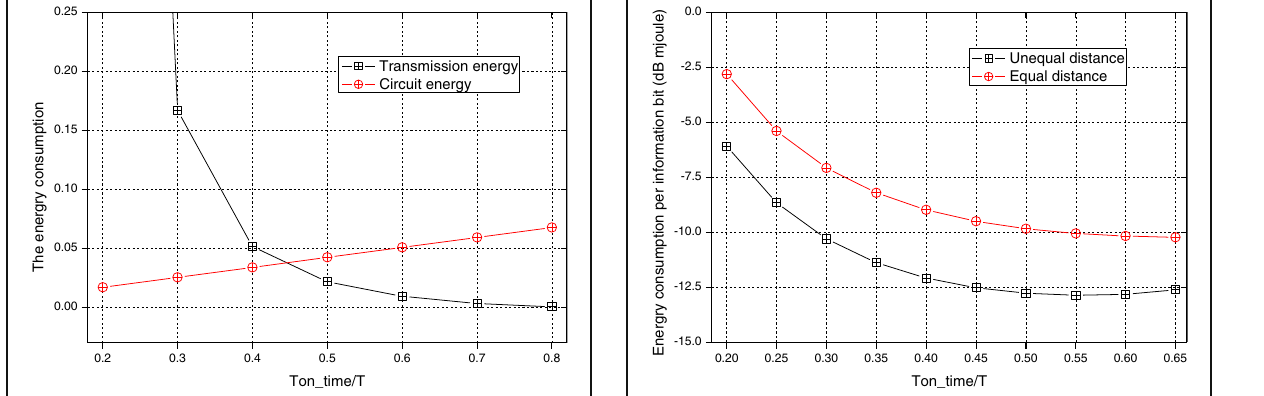
Fig. 9 The maximum energy consumption under UDNP and EDNP (MQAM)